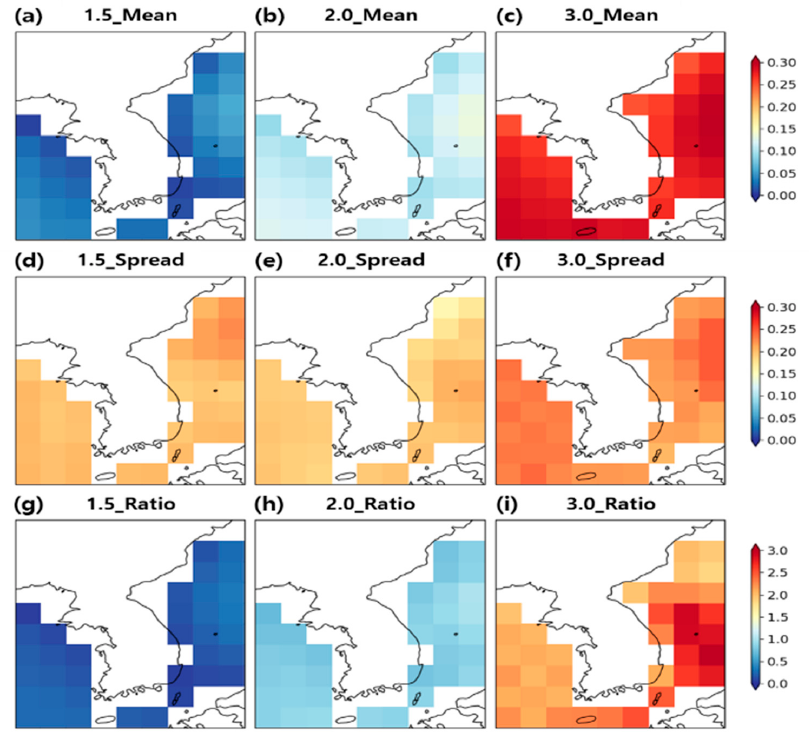
Figure 3. Projection of total SLR around the Korean Peninsula from CMIP6 models ( a – c ) and their spread ( d – f ) for three Paris Climate targets (T15 (left column), T20 (mid column), and T30 (right column)). The ratio of mean and spread ( g – i ) of CMIP6 models is shown in the bottom row. The unit of SLR is m.